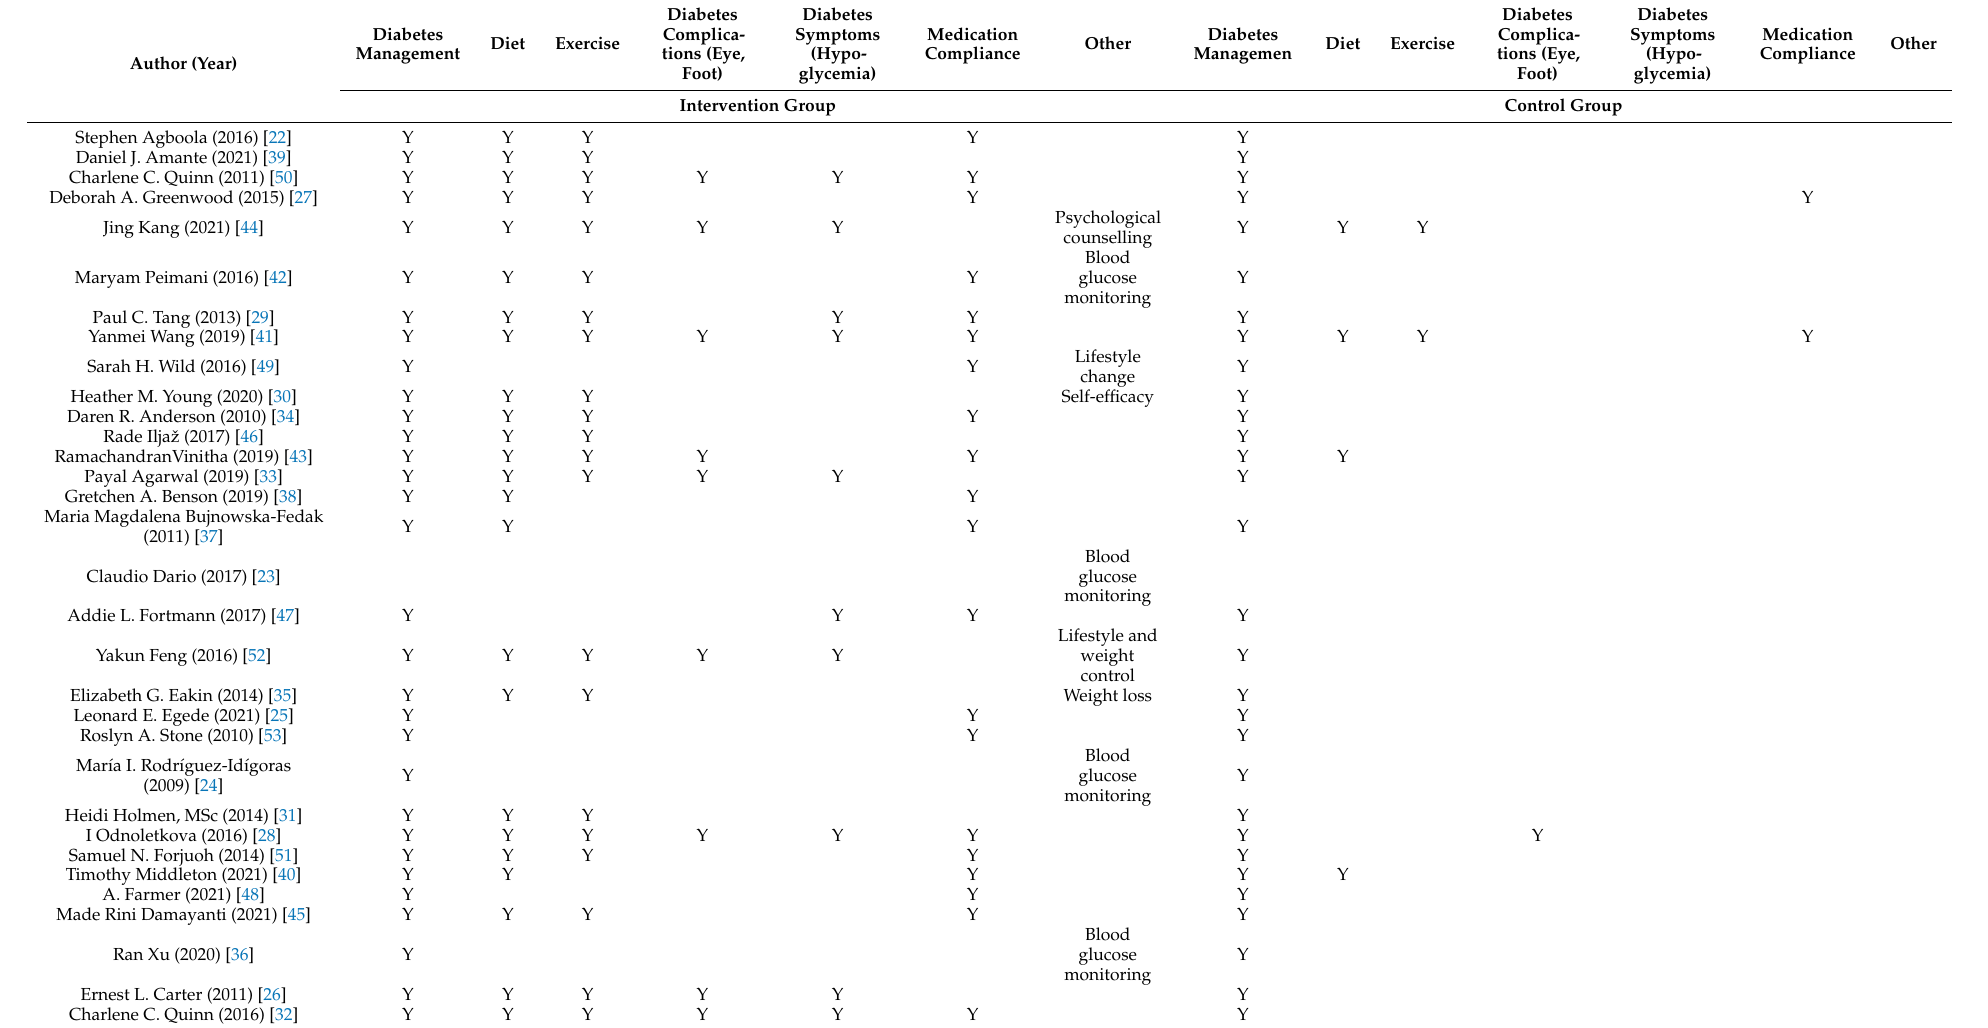
Table 2. Characteristics of telemedicine